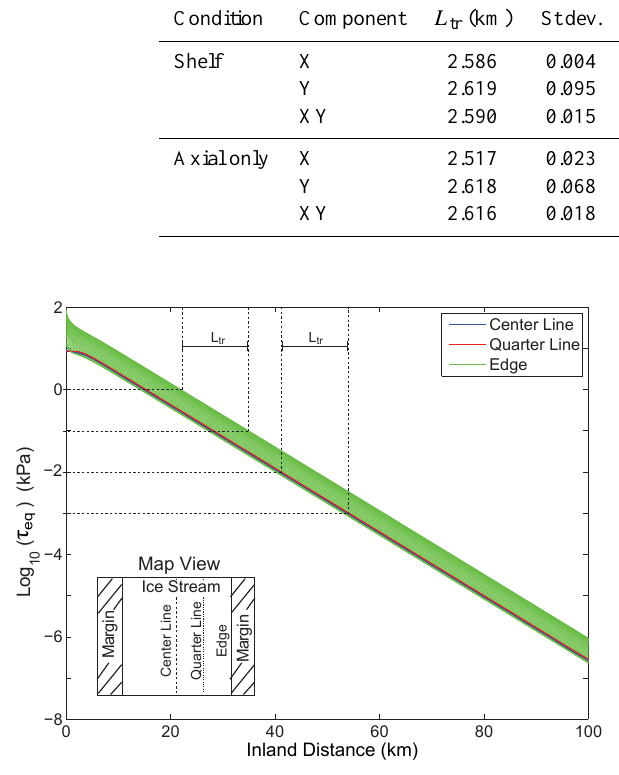
Table 3. Length scales for the transmission of tidal stress ( L tr ) for the 2-D models shown in Figs. 3 and 4. See text for description of how the parameters are estimated. All but one of the cases have low standard deviations. In the cases marked with an asterisk, the standard deviation is large since the value of σ x falls to zero near the (vertical) center of the ice stream, causing L tr to vary significantly near these locations. Near the top and bottom of the ice stream, the values of L tr for σ x are consistent with the values for the other components of stress. Fixed base Sliding base Condition Component L tr (km) St dev. Condition Component L tr (km) St. dev.